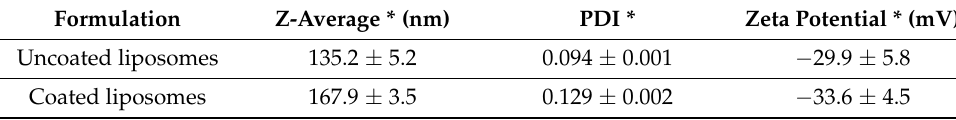
Table 3. Analysis of particle size, PDI, and zeta potential of uncoated and coated liposomes.